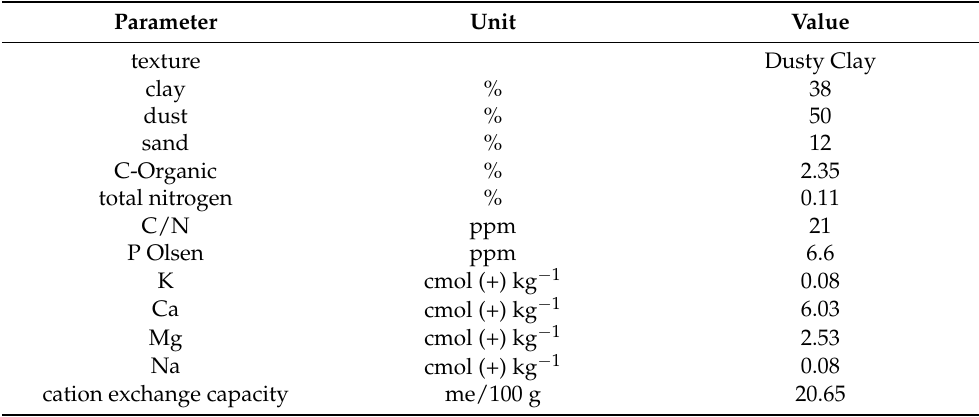
Table 1. Soil status of study